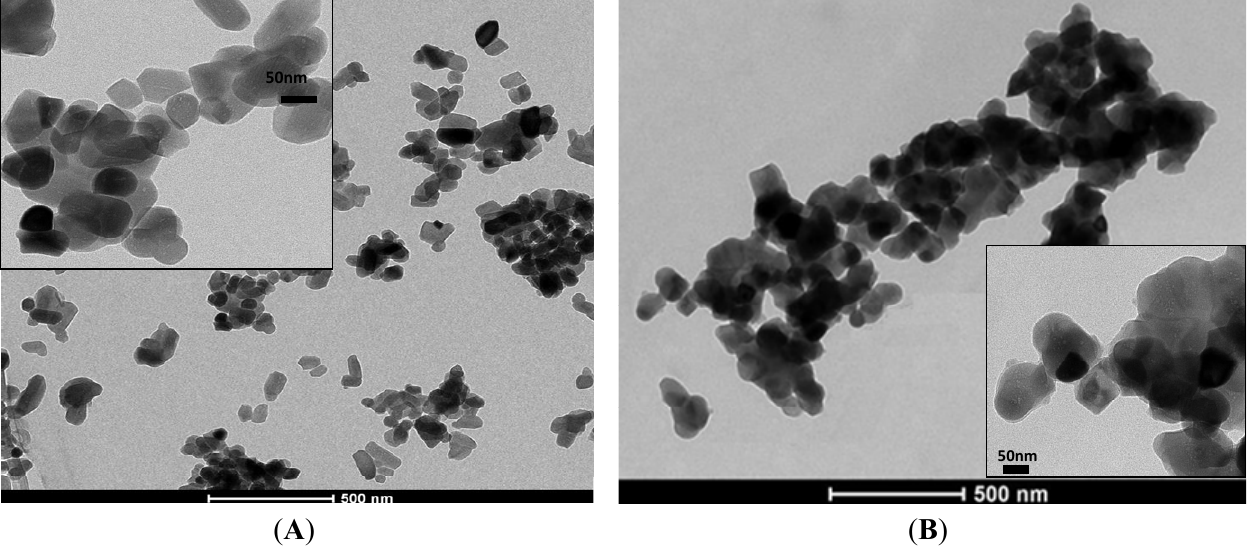
Figure 10. Typical TEM images of HA_900 ( A ) and Nb-HA_900 ( B ).